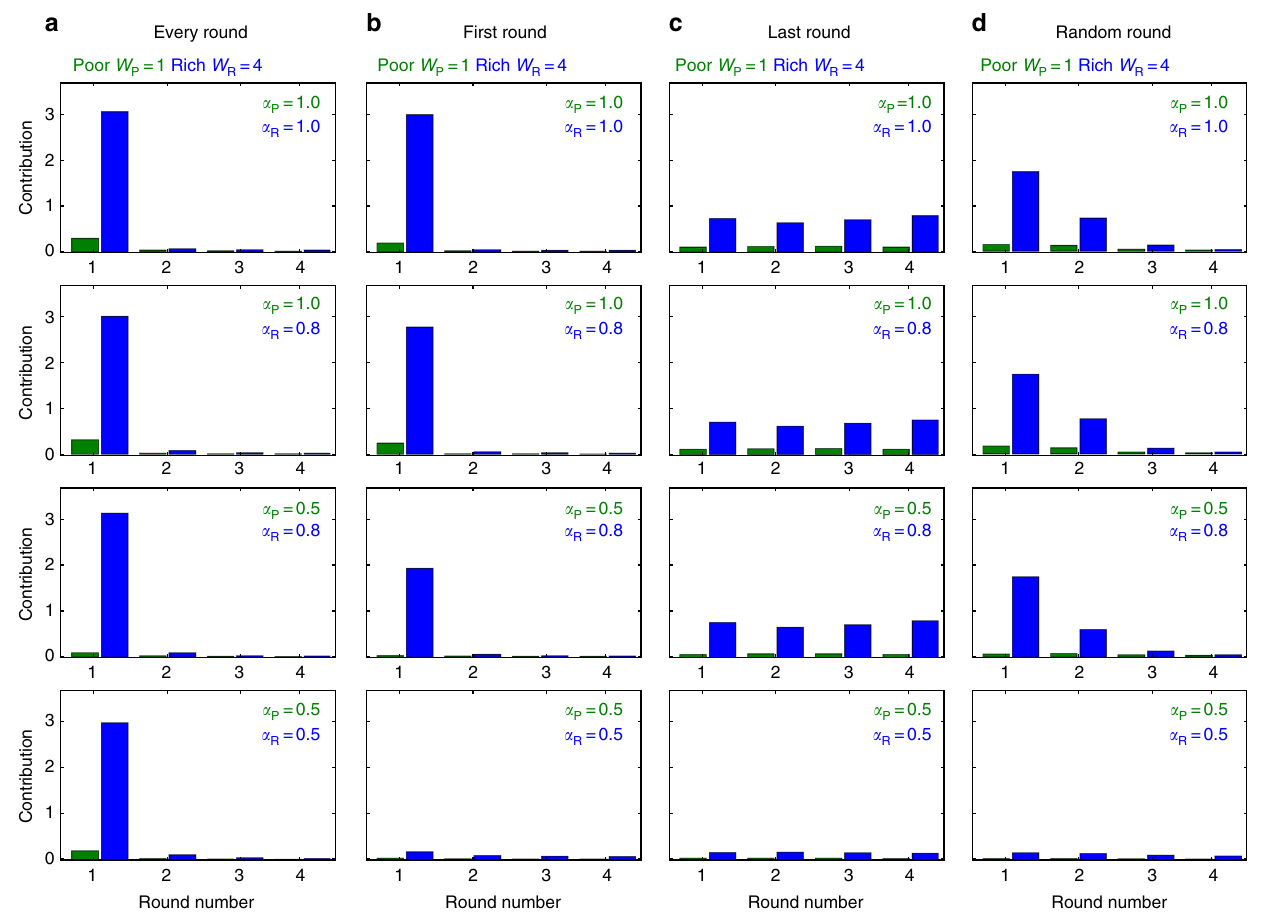
Fig. 4 Contributions for different timings of potential losses in a four-round game. The graphs depict average contributions in each round of a four-round game with a potential loss in a every round, b the fi rst round, c the last, or d a random round (games are pair-wise, p ¼ 1 þ exp λ 3 C r W initial wealth of both players W 0 = W R,0 + W P,0 = 4 + 1 = 5, population size N = 100, 1000 games per generation, mutation rate μ = 0.03, and the standard deviation for mutations in the individual decision thresholds τ r is set to σ =